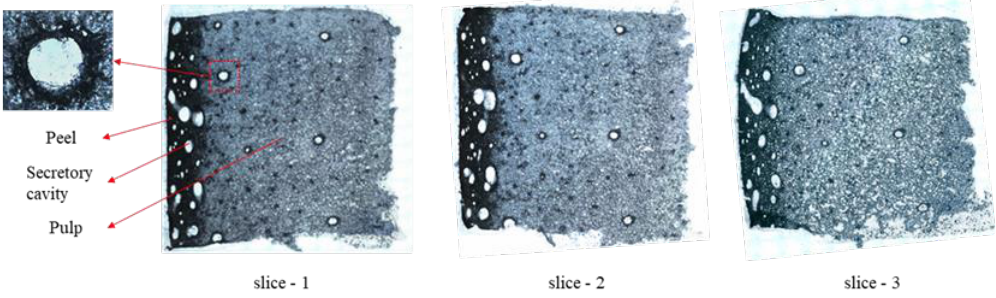
Figure 1. Microstructure of mango tissue slice, ×